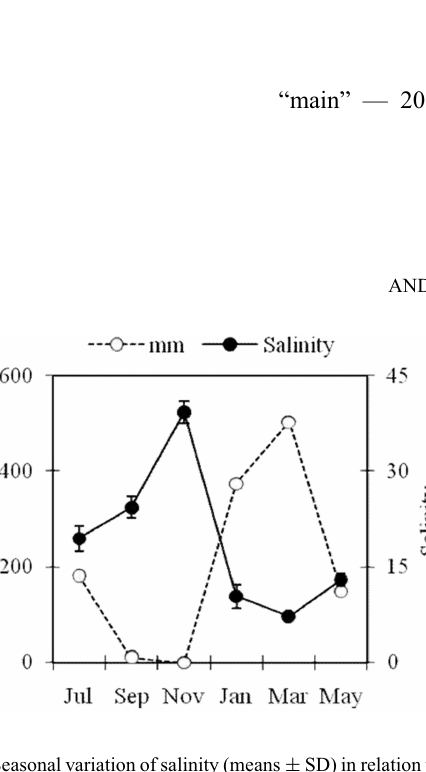
A total of 30 Copepoda taxa were identified (Table I).